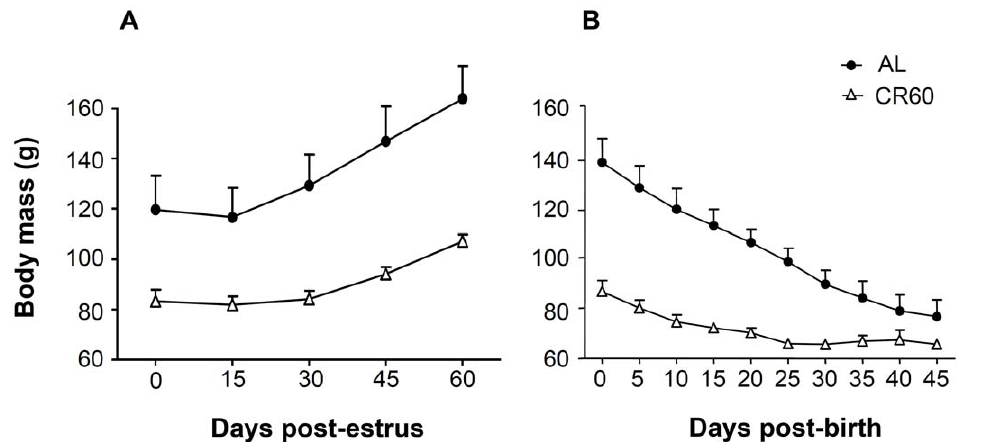
Figure 1. Effect of food availability on body mass over (A) gestation and (B) lactation. Body mass ( 6 SEM) of females fed ad libitum (AL) and calorie restricted females (CR60) (A) during the two months following oestrus, and (B) during the 45 days after birth.